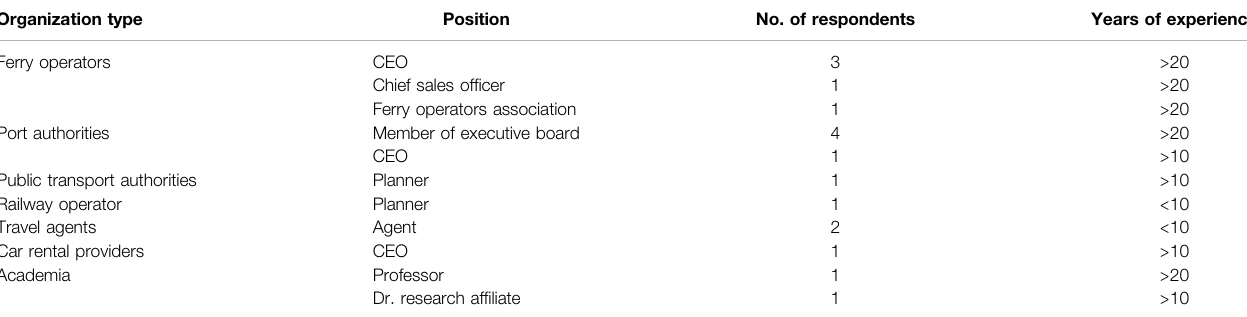
TABLE 1 | Characteristics of the